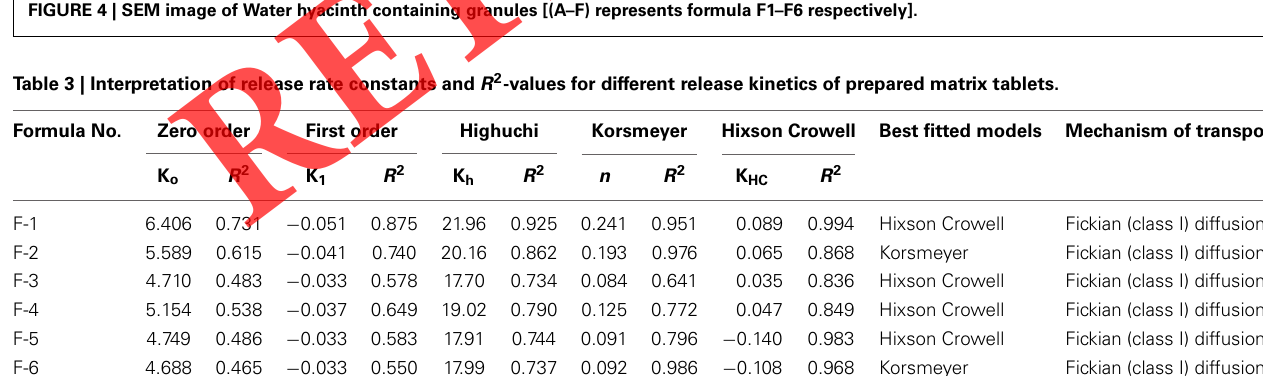
FIGURE 4 | SEM image of Water hyacinth containing granules [(A–F) represents formula F1–F6 respectively].